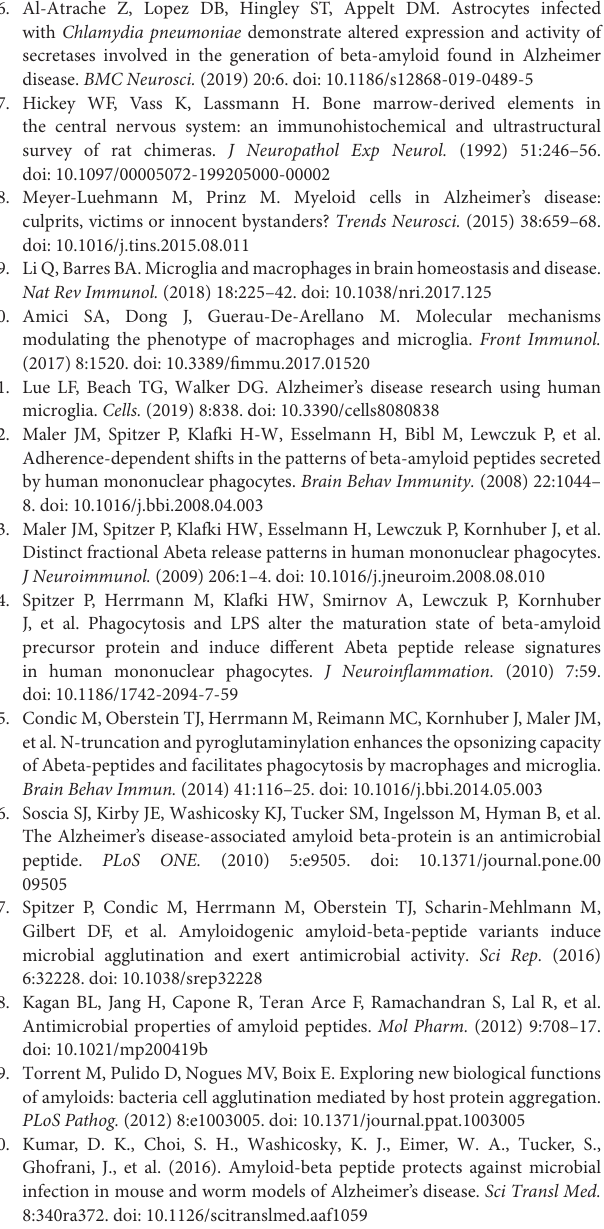
Supplementary Figure 1 | Timeline of experimental procedures. Supplementary Figure 2 | No reduction of macrophage viability by the inhibitors of APP metabolism and transfection. Supplementary Figure 3 | Structure of the tripartite ?-secretase inhibitor TGL-189. Supplementary Figure 4 | Time- and dose-dependency of